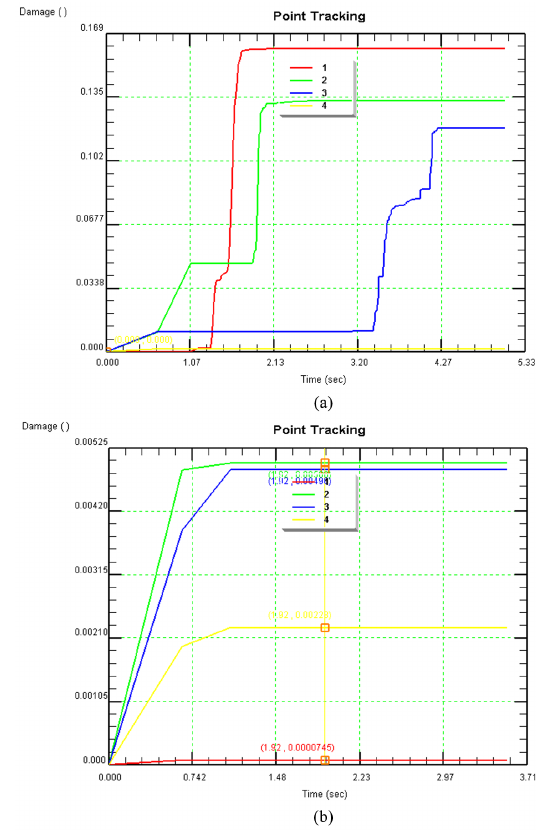
Figure 8. Comparison of damage values for four points tracking with different extrusion ratios: (a) 11.6 and (b)